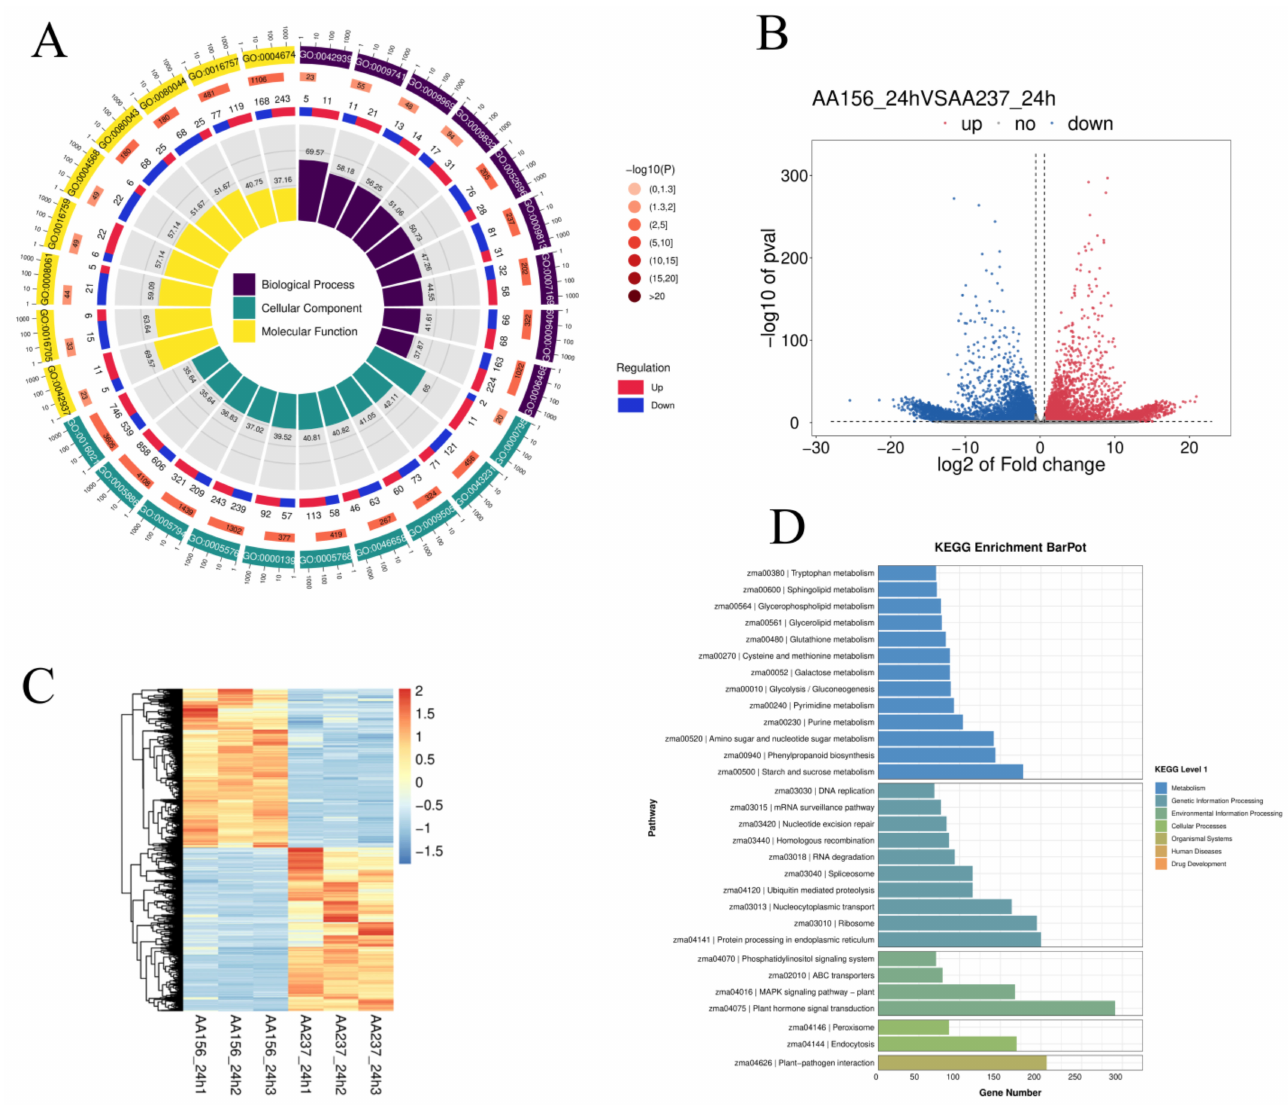
Figure 6. Analysis of differentially expressed genes in transcriptome. ( A ) Gene ontology LoopCircos of DEGs. ( B ) The volcano map of differentially expressed genes. ( C ) Hierarchical clustering of DEGs expression. ( D ) KEGG enrichment analysis of